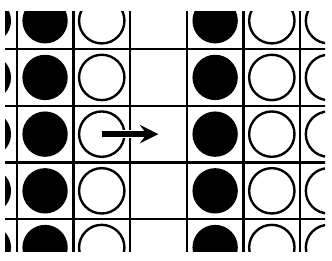
Figure 7. Wall’s WHITE moves.